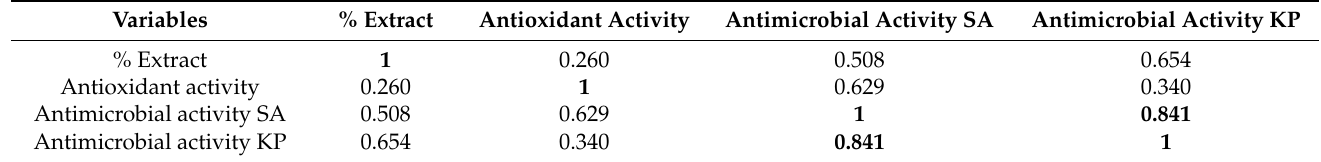
Table 6. Pearson correlation